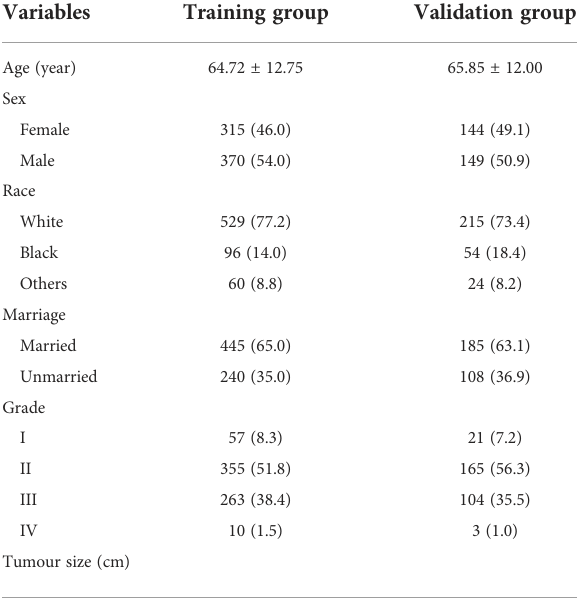
TABLE 1 Patient demographics and clinicopathological